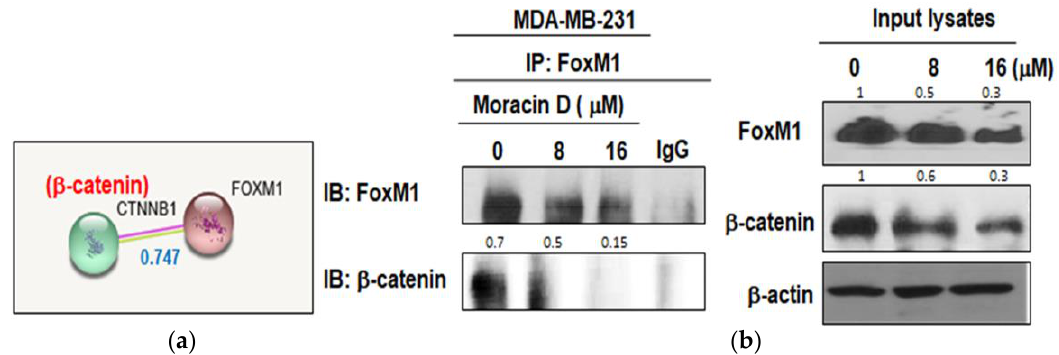
Figure 4. Effect of Moracin D on interaction between FOXM1 and β -catenin in MDA-MB-231 cells. ( a ) STRING database shows interaction score between FOXM1 and β -catenin. Blue number text (interaction score: 0.747). ( b ) MDA-MB-231 cells were treated with Moracin D and Immunoprecipitation (IP) was performed with protein lysates from MDA-MB-231 cells using anti-FOXM1 antibody and then Western blot analysis was performed to detect β -catenin and FOXM1 in input lysates. Input lysates indicate 5% pre-immunoprecipitated samples and β -actin levels confirm equivalent protein loading.